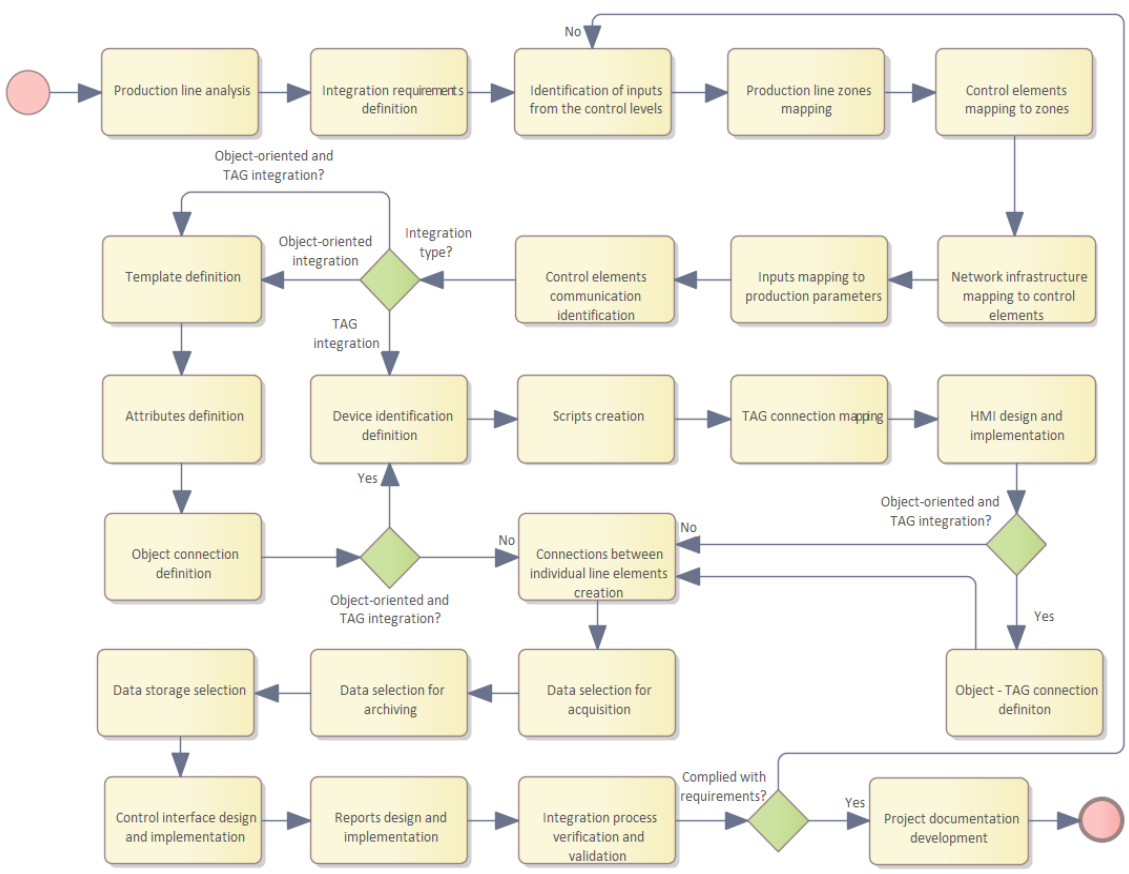
Figure 7. General proposal for an industrial integration process.